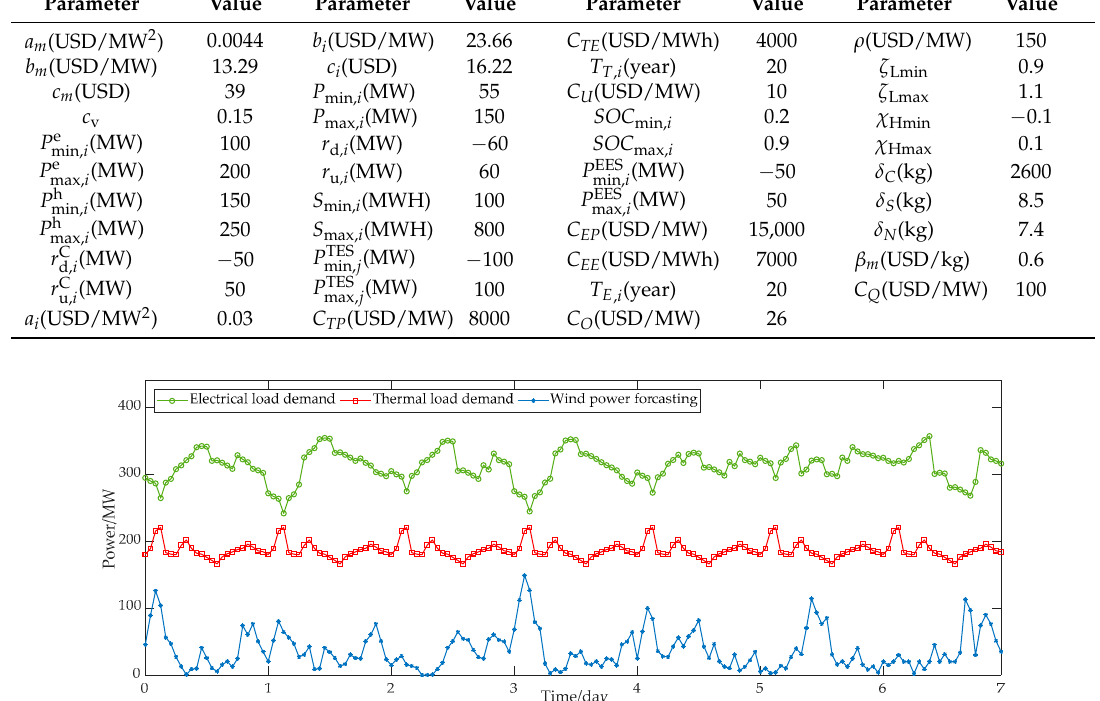
Figure 4. Curve of Figure 4. Curve of prediction.